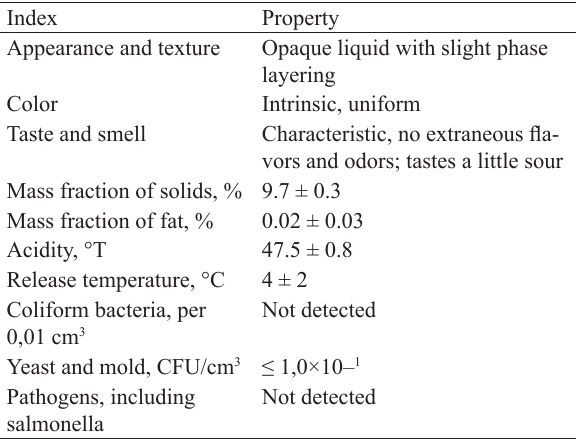
Table 3 Sensory, physico-chemical, and microbiological indicators of the functional whey drink fortified with Rhodiola rosea L. concentrate